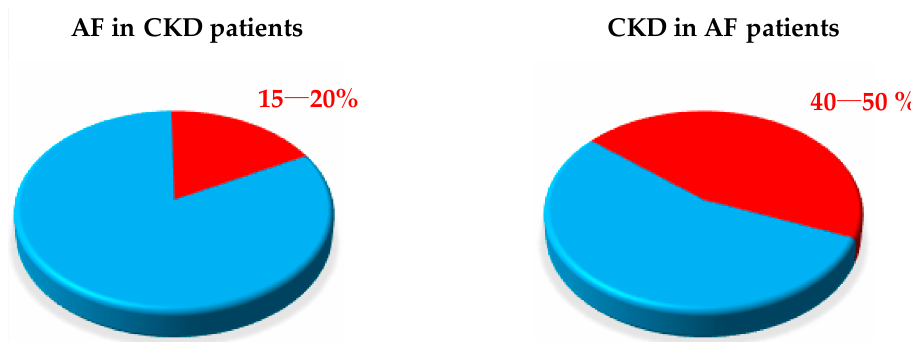
Figure 1. Prevalence of atrial fibrillation (AF) in chronic kidney disease (CKD) patients and vice versa.